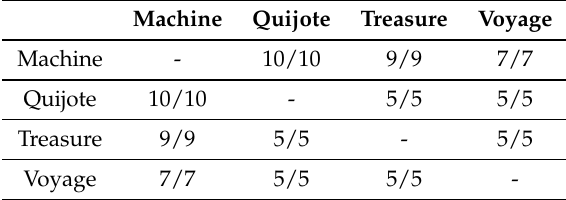
Table 21. Test results for dissimilar plain text files with sdhash.